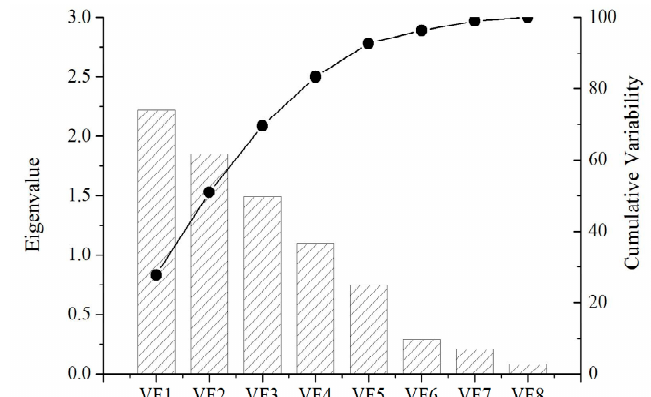
Figure 9. Scree plot of varimax rotated factors.